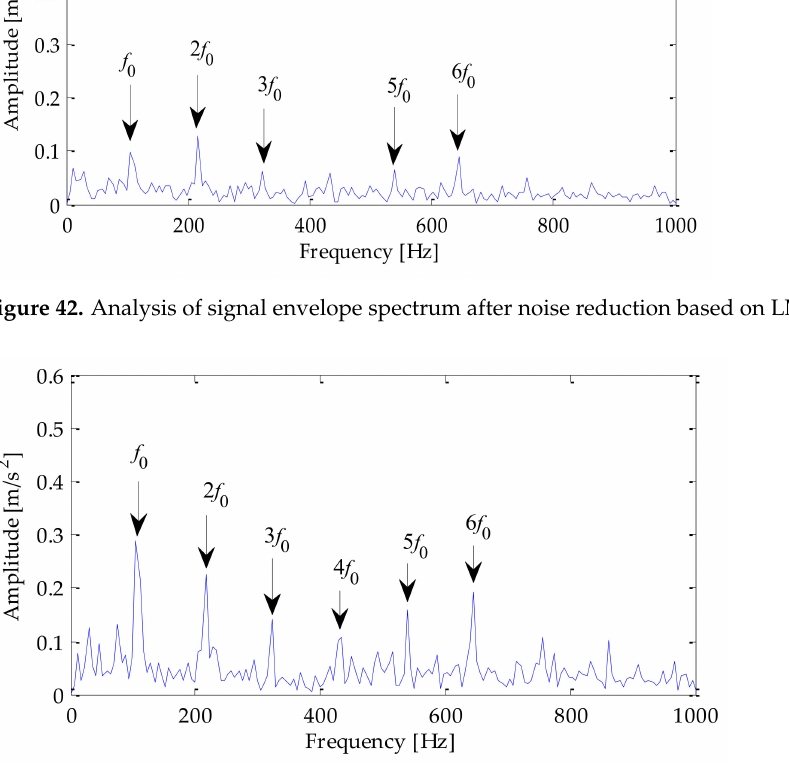
Figure 43. Analysis of signal envelope spectrum after noise reduction based on